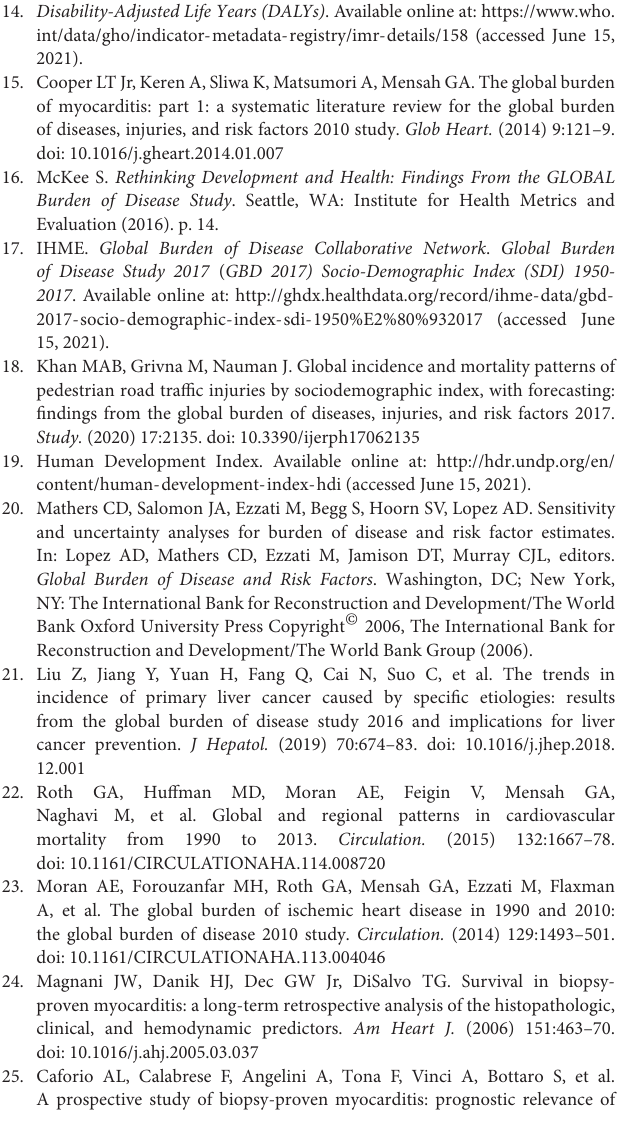
of myocarditis between 1990 and 2017. (B) The relative change in myocarditis-related deaths between 1990 and 2017. (C) The relative change in DALY cases of myocarditis between 1990 and 2017. ASIR, age-standardized incidence rate; ASDR, age-standardized death rate; DALY, disability-adjusted life year; EAPC, estimated annual percentage change. Supplementary Figure 2 | The global death burden of myocarditis in 195 countries and territories. (A) The absolute number of myocarditis incidence cases in 2017. (B) The ASDR (per 100,000 persons) of myocarditis in 2017. (C) The EAPC of myocarditis ASDRs between 1990 and 2017. ASDR, age-standardized death rate; EAPC, estimated annual percentage change. Supplementary Figure 3 | The global DALY burden of myocarditis in 195 countries and territories. (A) The absolute number of myocarditis DALY cases in 2017. (B) The age-standard DALY rate (per 100,000 persons) of myocarditis in 2017. (C) The EAPC of myocarditis age-standardized DALY rate between 1990 and 2017. DALY, disability-adjusted life year; EAPC, estimated annual percentage